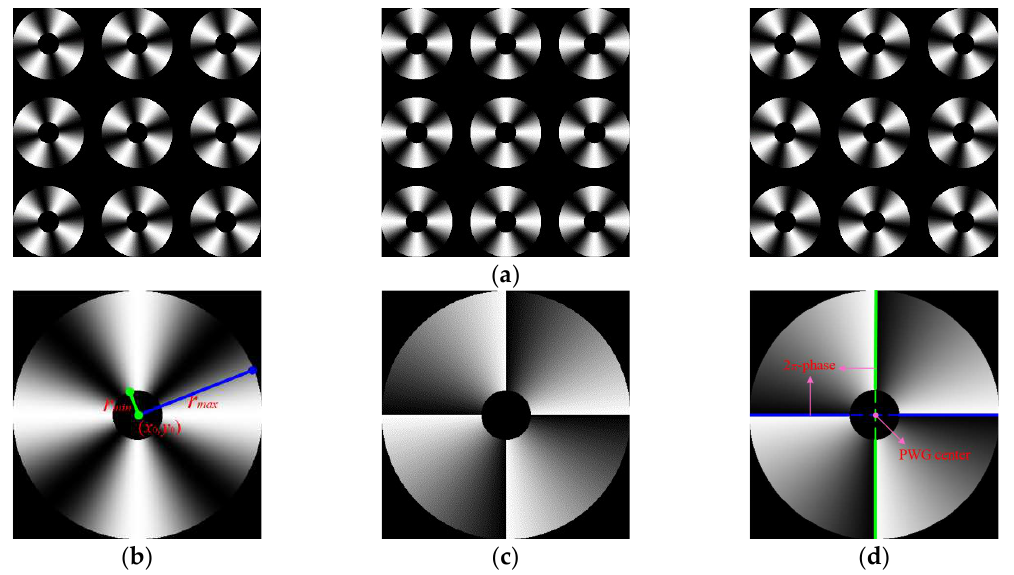
Figure 1. Phase-shifting wedge grating (PWG) pattern. ( a ) Three PWG arrays; ( b ) a single PWG; ( c ) its wrapped phase; and, ( d ) detected 2π-phase lines and their intersection.